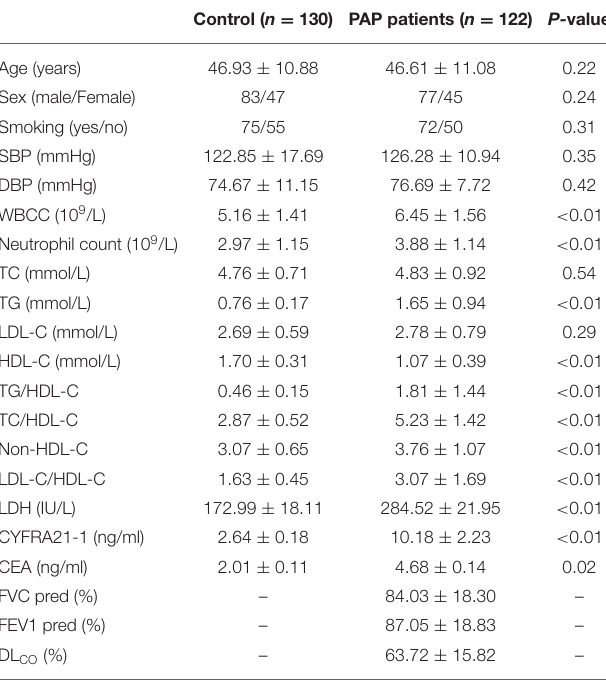
TABLE 1 | Demographic and clinical characteristics of the patients and healthy subjects.